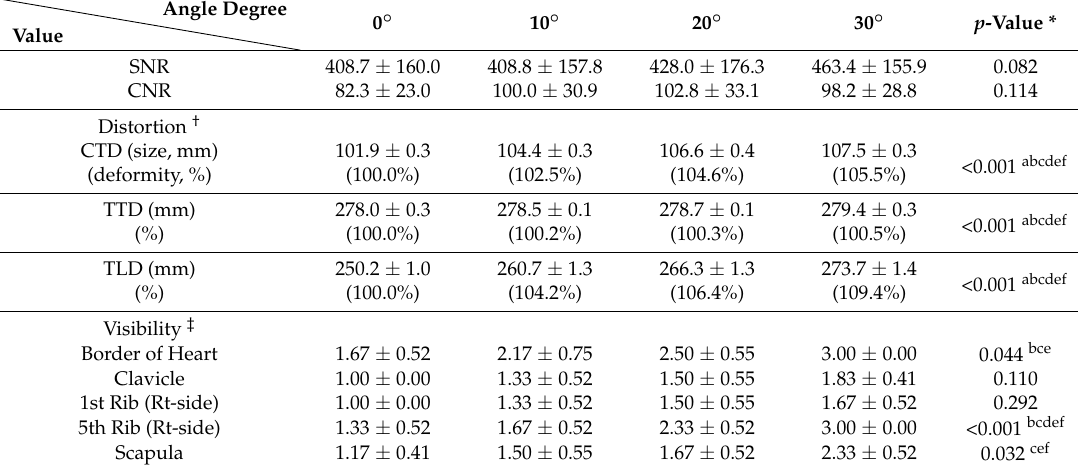
Table 2. SNR, CNR, distortion and visibility values on chest AP images according to different angles.